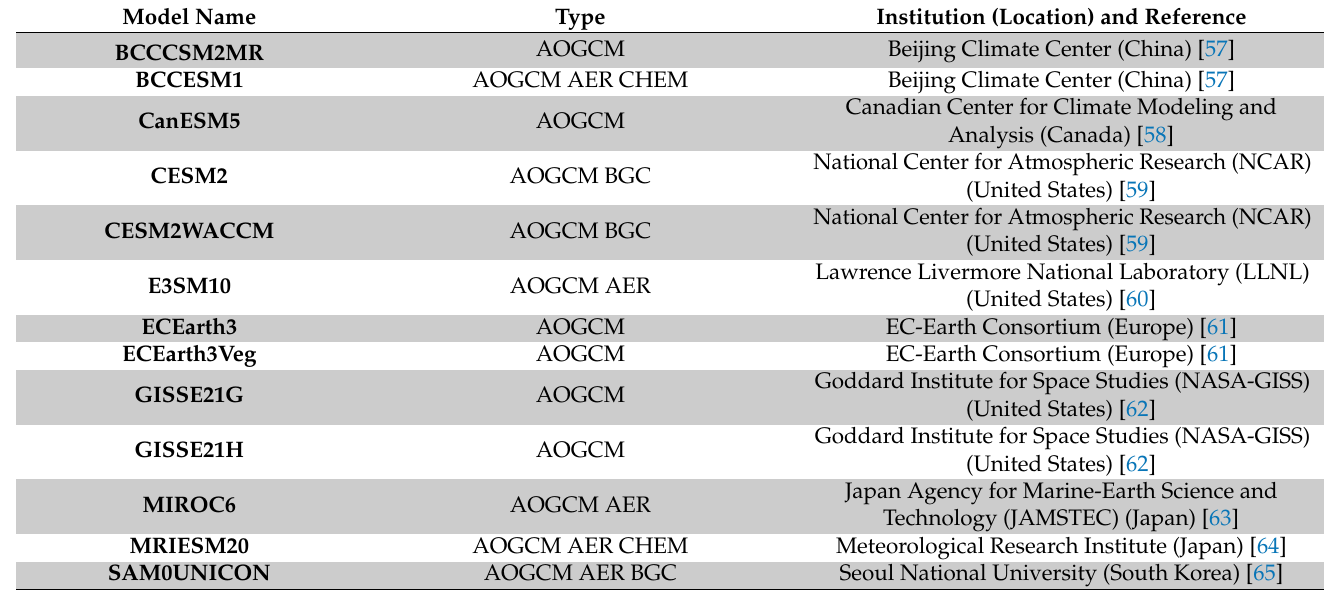
Table 1. GCMs used in evaluation including type, institution (location), and corresponding